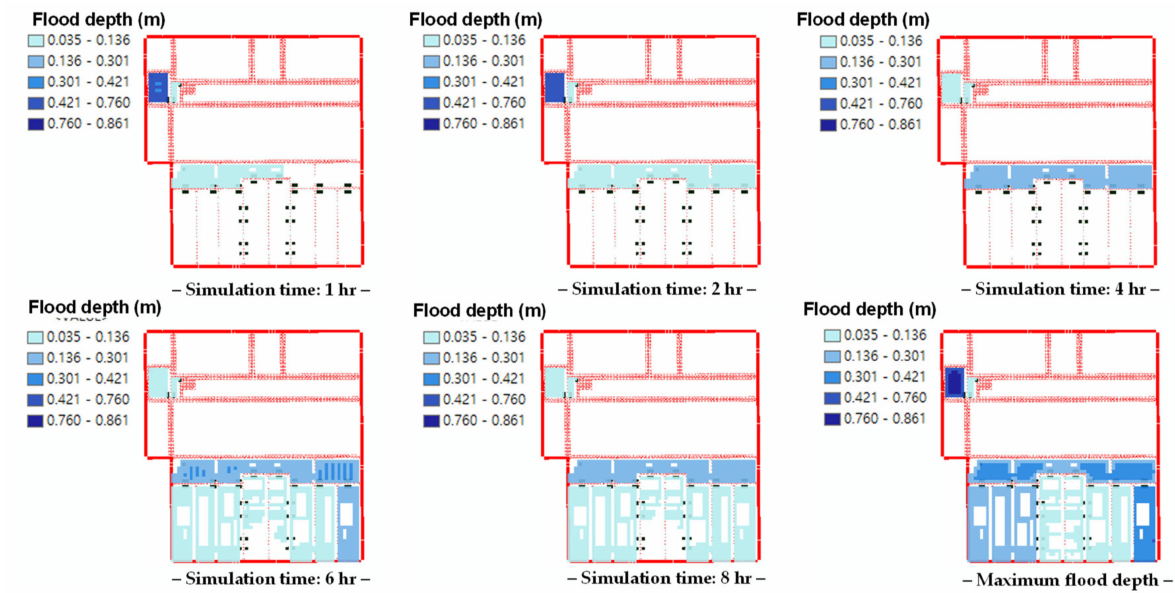
Figure 12. 2D internal flood analysis for a return period of 10 7 years (NPP